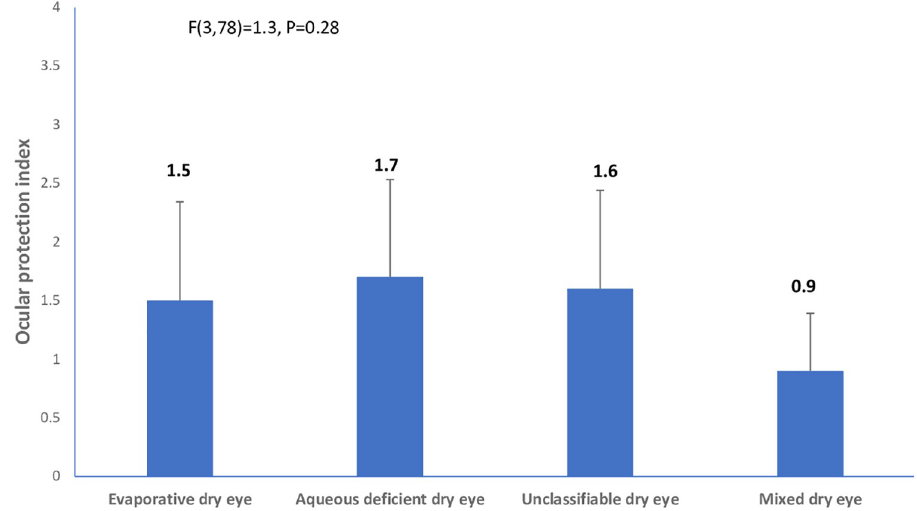
Fig 6. Means of ocular protection index across clinical subtypes of dry eye.